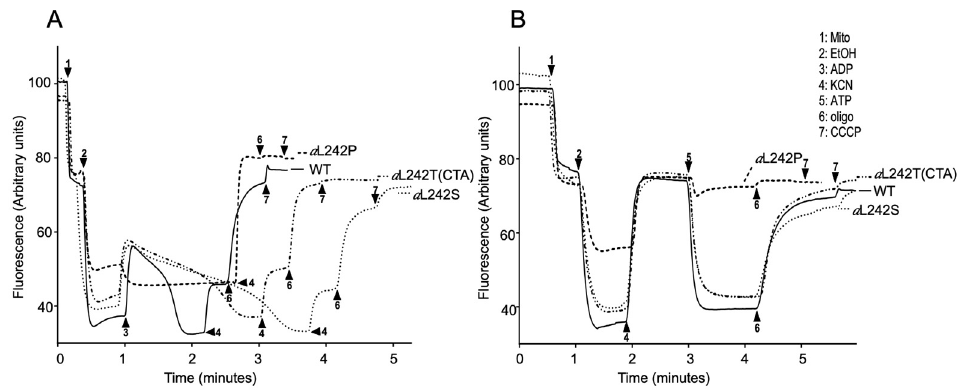
Figure 4. Mitochondrial membrane potential. Variations in mitochondrial ∆Ψ were monitored by fluorescence quenching of Rhodamine 123, using intact, osmotically-protected, mitochondria from wild type ( WT ) and mutant strains a L242P, a L242T and a L242S grown for 24 h at 28 ◦ C in rich galactose liquid media until a density of 2-3 OD 600nm (these mitochondrial preparations are the same as those used in Figure 2). The tracings in ( A ) show how the mitochondria respond to externally added ADP, those in ( B ) reflect ATP-driven proton-pumping by ATP synthase. The additions were 25 µ g / mL Rhodamine 123, 0.15 mg / mL Mito, 10 µ L EtOH, 75 µ M ADP, 2 mM KCN, 0.2 mM ATP, 4 µ g / mL oligo, and 4 µ M CCCP. The shown fluorescence tracings are representative of at least three experiments.